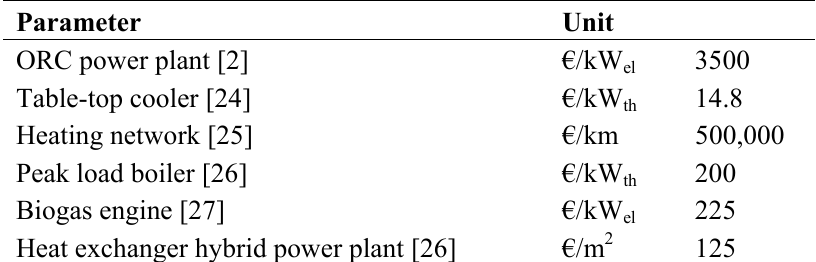
Table 3. Specific costs for power plant units and